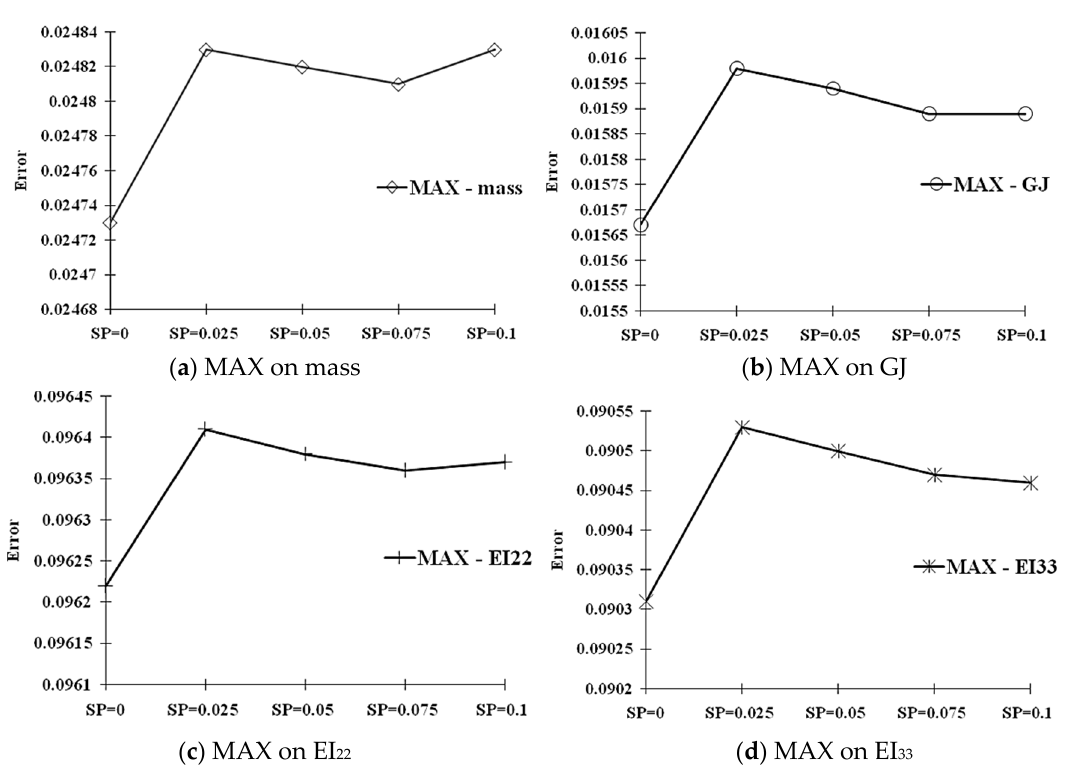
Figure 14. Maximum error according to variation of SPP.